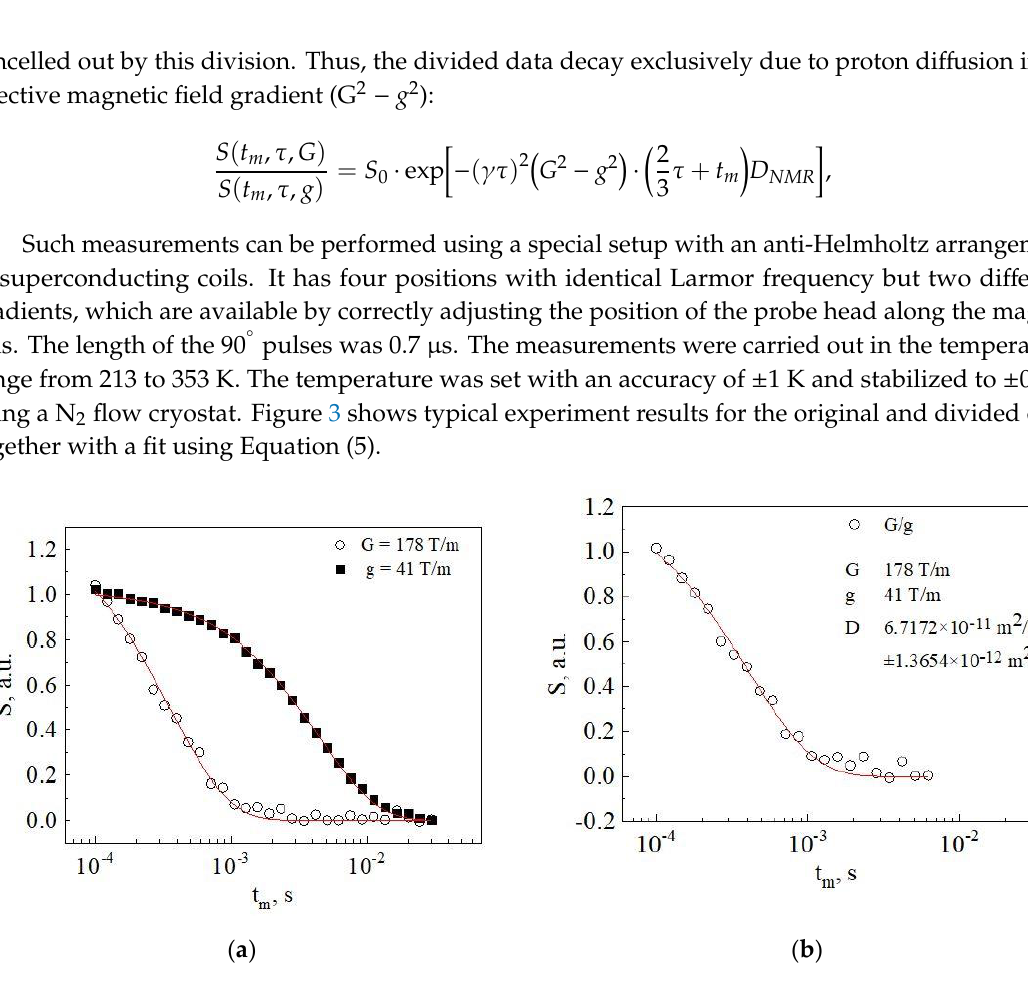
Figure 3. Results from SFG NMR at 273 K: ( a ) decays of the stimulated-echo signal amplitude as a function of the mixing time t m for the indicated values of the magnetic field gradient and an evolution time of t e = 100 μs; and ( b ) ratio of the data for the different field gradients and fit (line) using Equation (5).